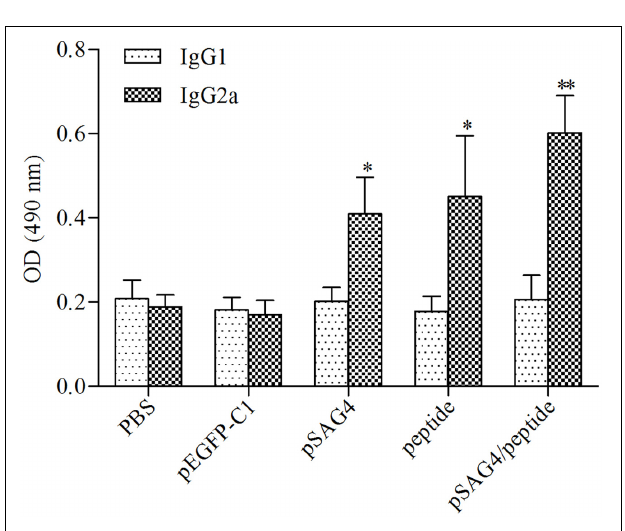
FIGURE 5 | Determination of specific anti- T. gondii IgG1 and IgG2a in immunized mice. The sera of 20 mice of each group were collected from 2 weeks after the final immunization and the IgG subtypes levels were analyzed by ELISA. T. gondii -specific IgG1 and IgG2a were used in the detection. Results are expressed as means of the OD490 ± SD statistically significant differences ( p < 0.05) compared to the control groups. Each sample was tested three times. ∗ Compared with PBS or pEGFP-C1, p < 0.05 and ∗∗ compared with pSAG4 or peptide, p <